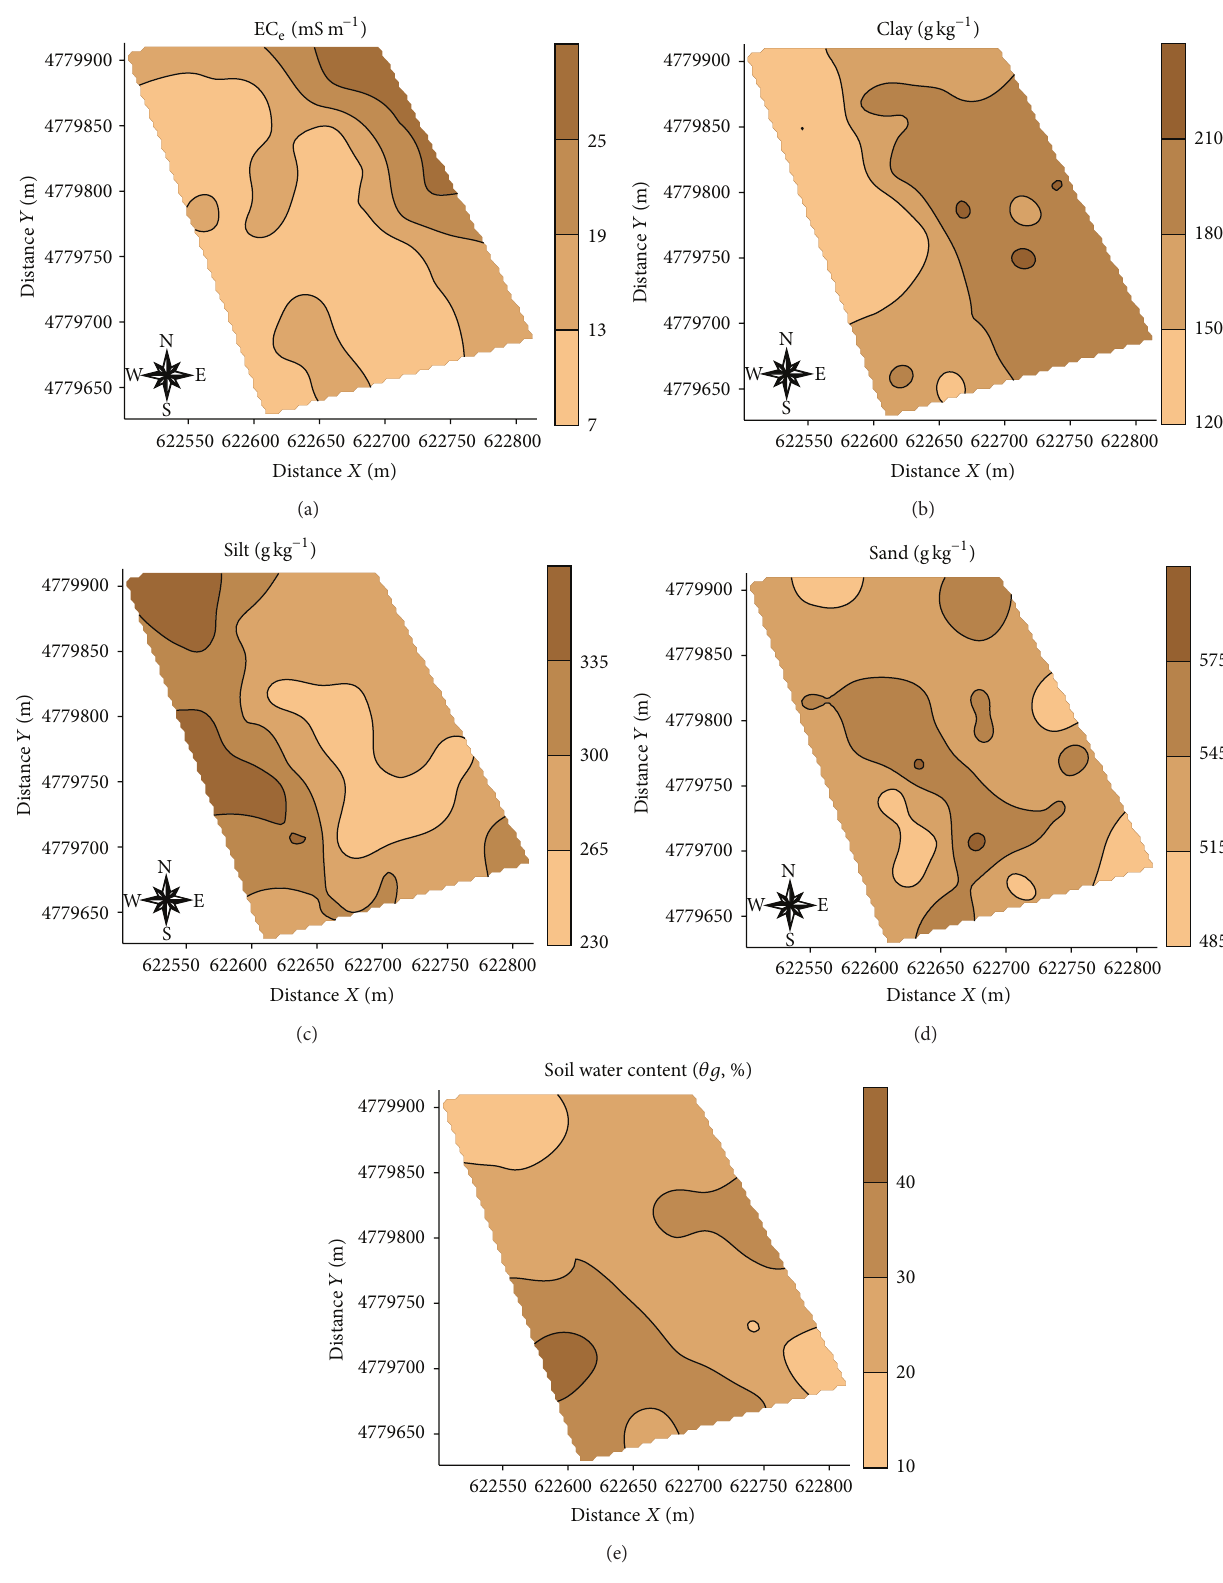
Figure 6: Kriging maps of the soil properties